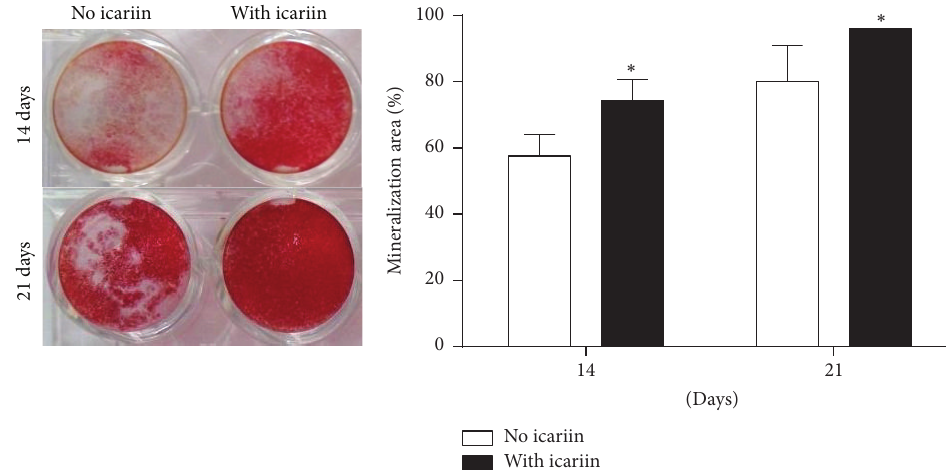
Figure 5: Mineralization assay of BMSCs with or without the stimulation of 10 −6 mol/L icariin for 14 days and 21 days. All data are presented as mean values together with the standard deviation (SD). ∗ 𝑝 < 0.05 indicating the statistical difference between the experimental group (with icariin) and the control group (no icariin) at the same time